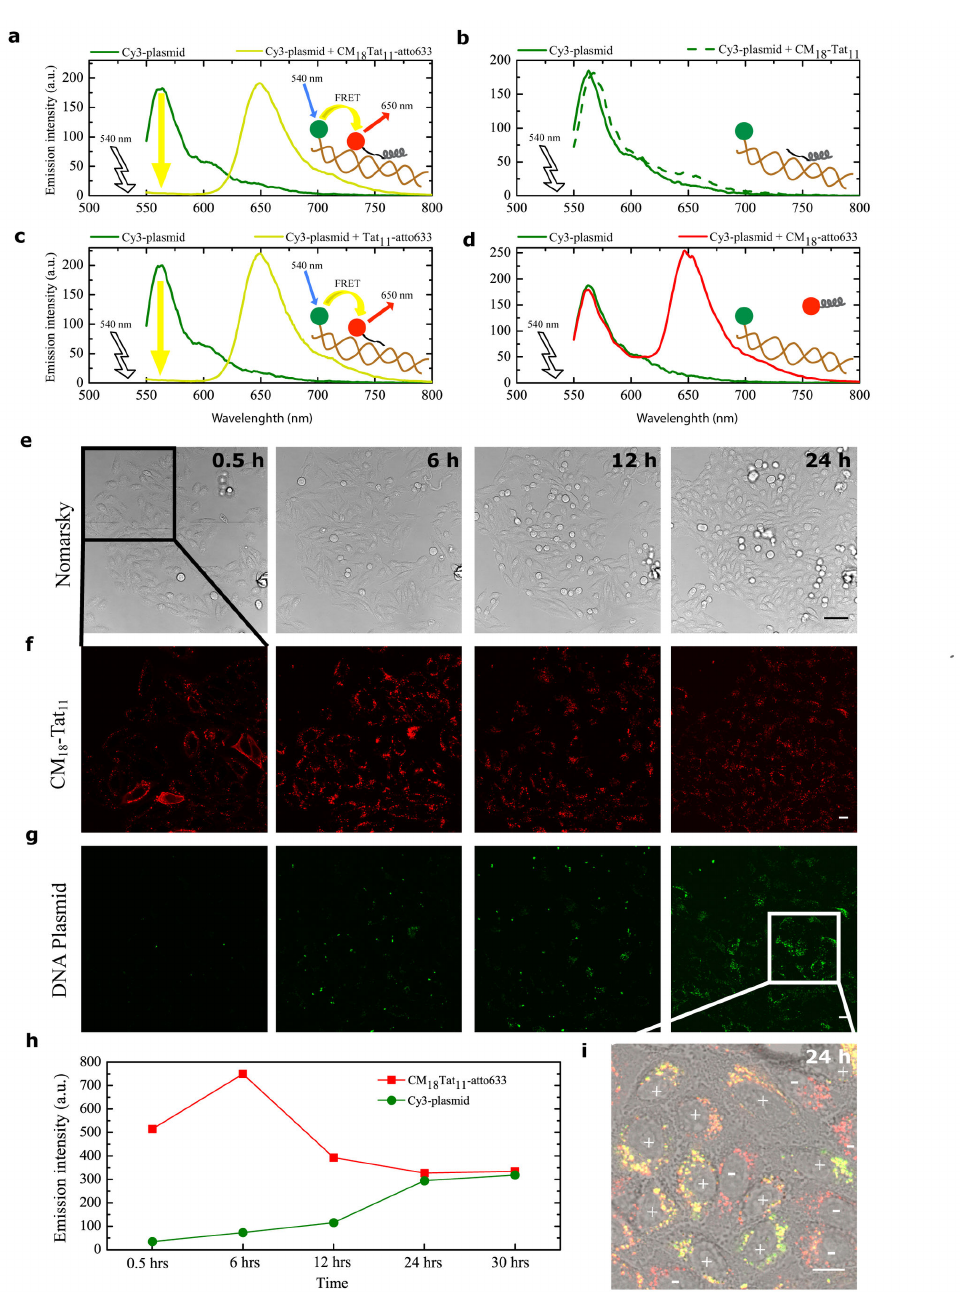
Figure 3. Spectroscopic properties and cell uptake dynamics of CM d ) Fluorescence spectra are recorded at 37 °C on a spectrofluorometer by exciting at 540 nm and collecting the fluorescence between 550 and 800 nm. First, a fluorescence emission measurement is performed on a PBS solution of Cy3-labeled DNA plasmid alone (solid green line in a, b, c, d). Then, atto633-labeled (dark yellow line in a) or unlabeled (dashed green line line in b) CM Tat or atto633-labeled Tat (dark yellow line in c) or atto633-labeled CM 11 11 emission spectrum recorded again ( e ) Nomarsky images of CLSM timelapse assay performed on cells incubated with CM atto633/Cy3-plasmid DNA binary complexes at N:P ratio 16:1 applying the same treatments used for a typical transfection experiment. Scale bars: 50 µm. ( f , g ) Panels show the fluorescence signal distribution of CM from the upper left quadrant of Figure 3e panels during the time-lapse. Scale bars: 10 µm. ( h ) Quantitative evaluation of CM atto633 (red line) and Cy3-plasmid DNA (green line) signals during the time-lapse acquisition. ( i ) 24 hours CM and Cy3-plasmid (g) panels zoom merge. Scale bars: 10 µm. doi: 10.1371/journal.pone.0070108.g003 PLOS ONE |